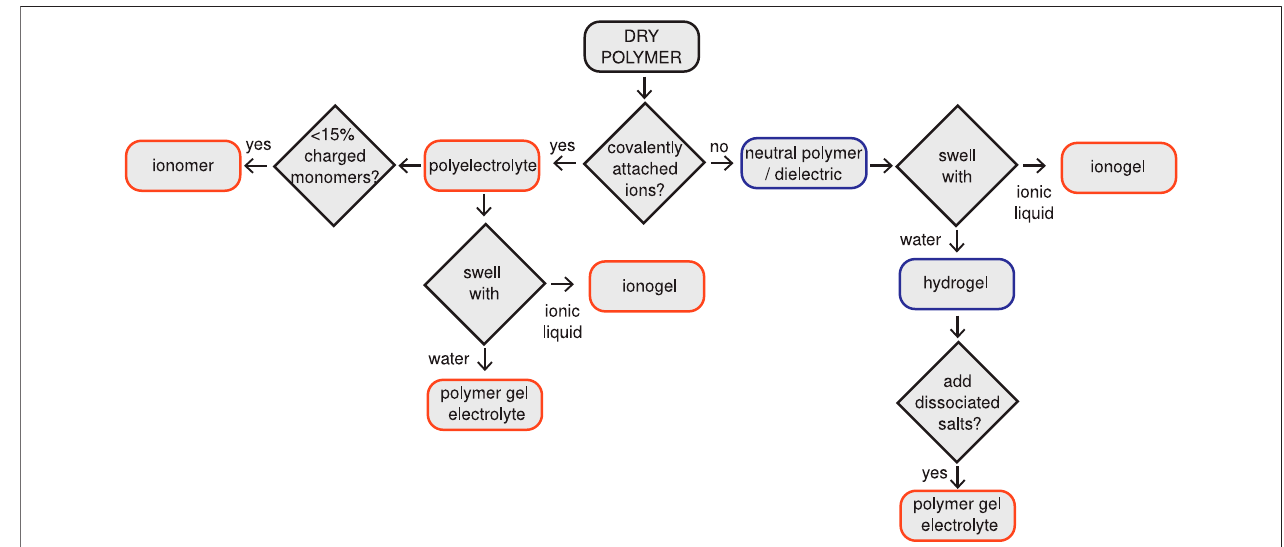
FIGURE 2 | Polymer naming convention used in this paper. Blue outlines indicate that the polymers are not ionically conductive, whereas the orange outlines indicate that the polymers are ionically conductive.